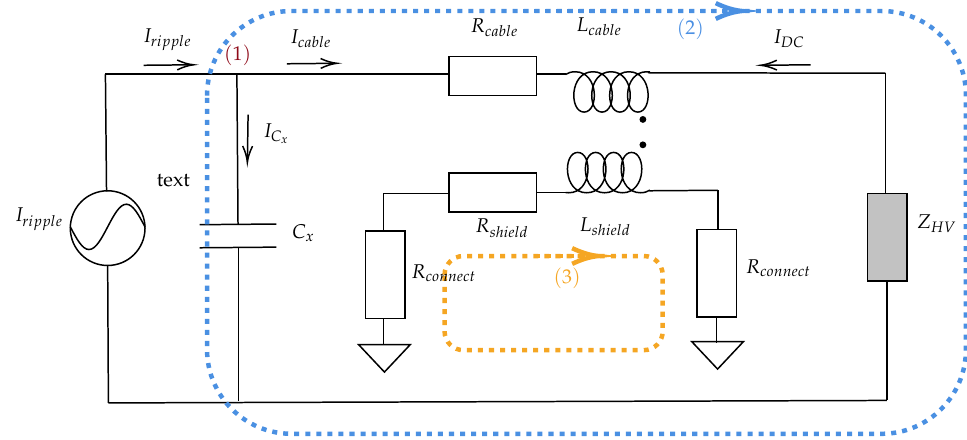
Figure 2. Simplified equivalent circuit representation of the examined system, with an individually shielded HV cable.